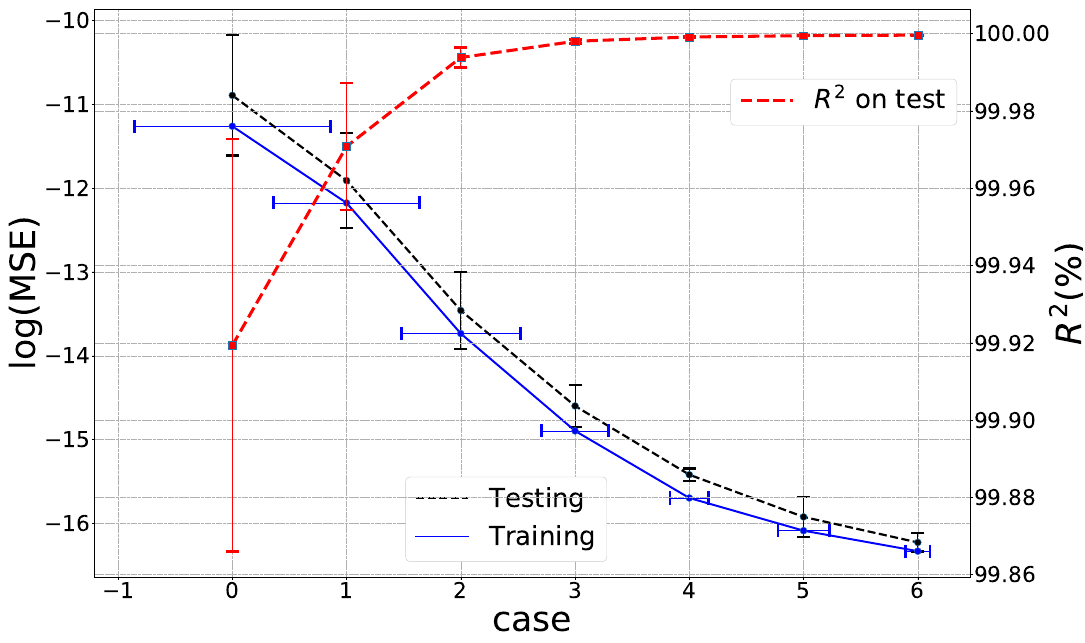
Figure 6. R 2 and MSE vs. size of the training set. The figure shows improvement in the loss, which is an indicator of the model